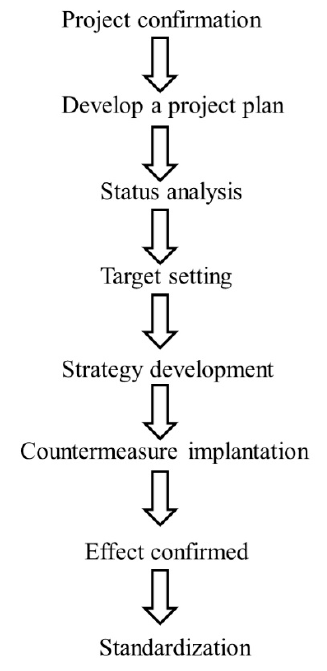
Figure 2. Flow chart of the project.